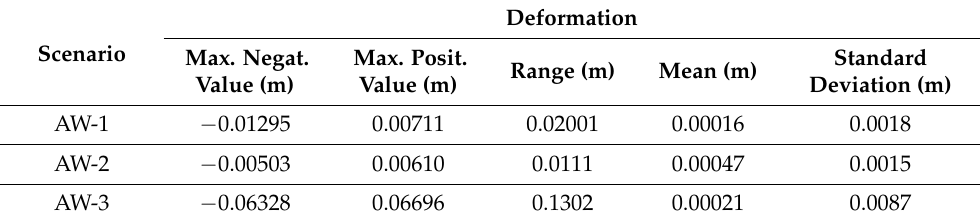
Table 3. Global deformation results of scenarios AW-1 to AW-3. Deformation Scenario Max. Negat. Max. Posit. Range (m) Mean (m) Value (m) Value (m)